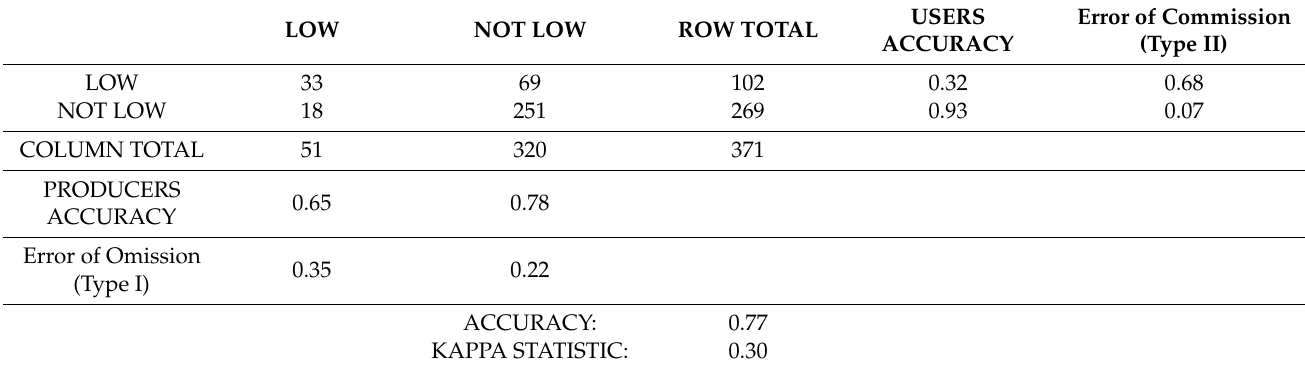
Error of Omission (Type I) 0.35